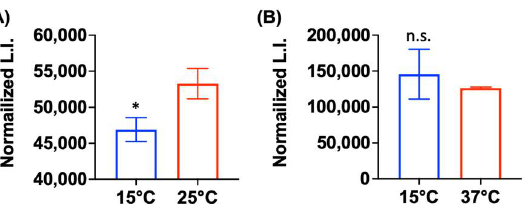
Figure 4. Psychrotolerant Pseudomonas sp. B14-6 displayed lower ATP levels at 15 °C vs. 25 °C. Intracellular ATP levels in Pseudomonas sp. B14-6 ( A ) or P . aeruginosa PA14 ( B ) were estimated by the luciferase reaction in lysed cell pellets. Luminescence intensity (L.I.) was normalized by cell concentration. Results are shown as mean ± SD; n = 3. Statistical differences were analyzed by t -test; * p < 0.05, n.s. not significant ( p > 0.05).